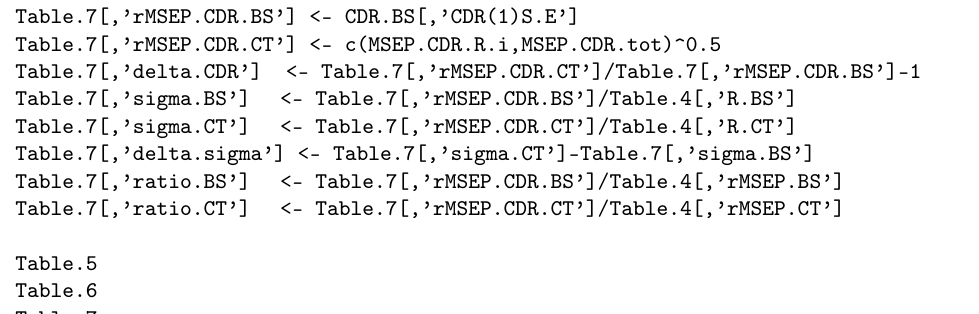
Table.7[,’rMSEP.CDR.BS’] <- CDR.BS[,’CDR(1)S.E’] Table.7[,’rMSEP.CDR.CT’] <- c(MSEP.CDR.R.i,MSEP.CDR.tot)^0.5 Table.7[,’delta.CDR’] <- Table.7[,’rMSEP.CDR.CT’]/Table.7[,’rMSEP.CDR.BS’]-1 Table.7[,’sigma.BS’] <- Table.7[,’rMSEP.CDR.BS’]/Table.4[,’R.BS’] Table.7[,’sigma.CT’] <- Table.7[,’rMSEP.CDR.CT’]/Table.4[,’R.CT’] Table.7[,’delta.sigma’] <- Table.7[,’sigma.CT’]-Table.7[,’sigma.BS’] Table.7[,’ratio.BS’] <- Table.7[,’rMSEP.CDR.BS’]/Table.4[,’rMSEP.BS’] Table.7[,’ratio.CT’] <-